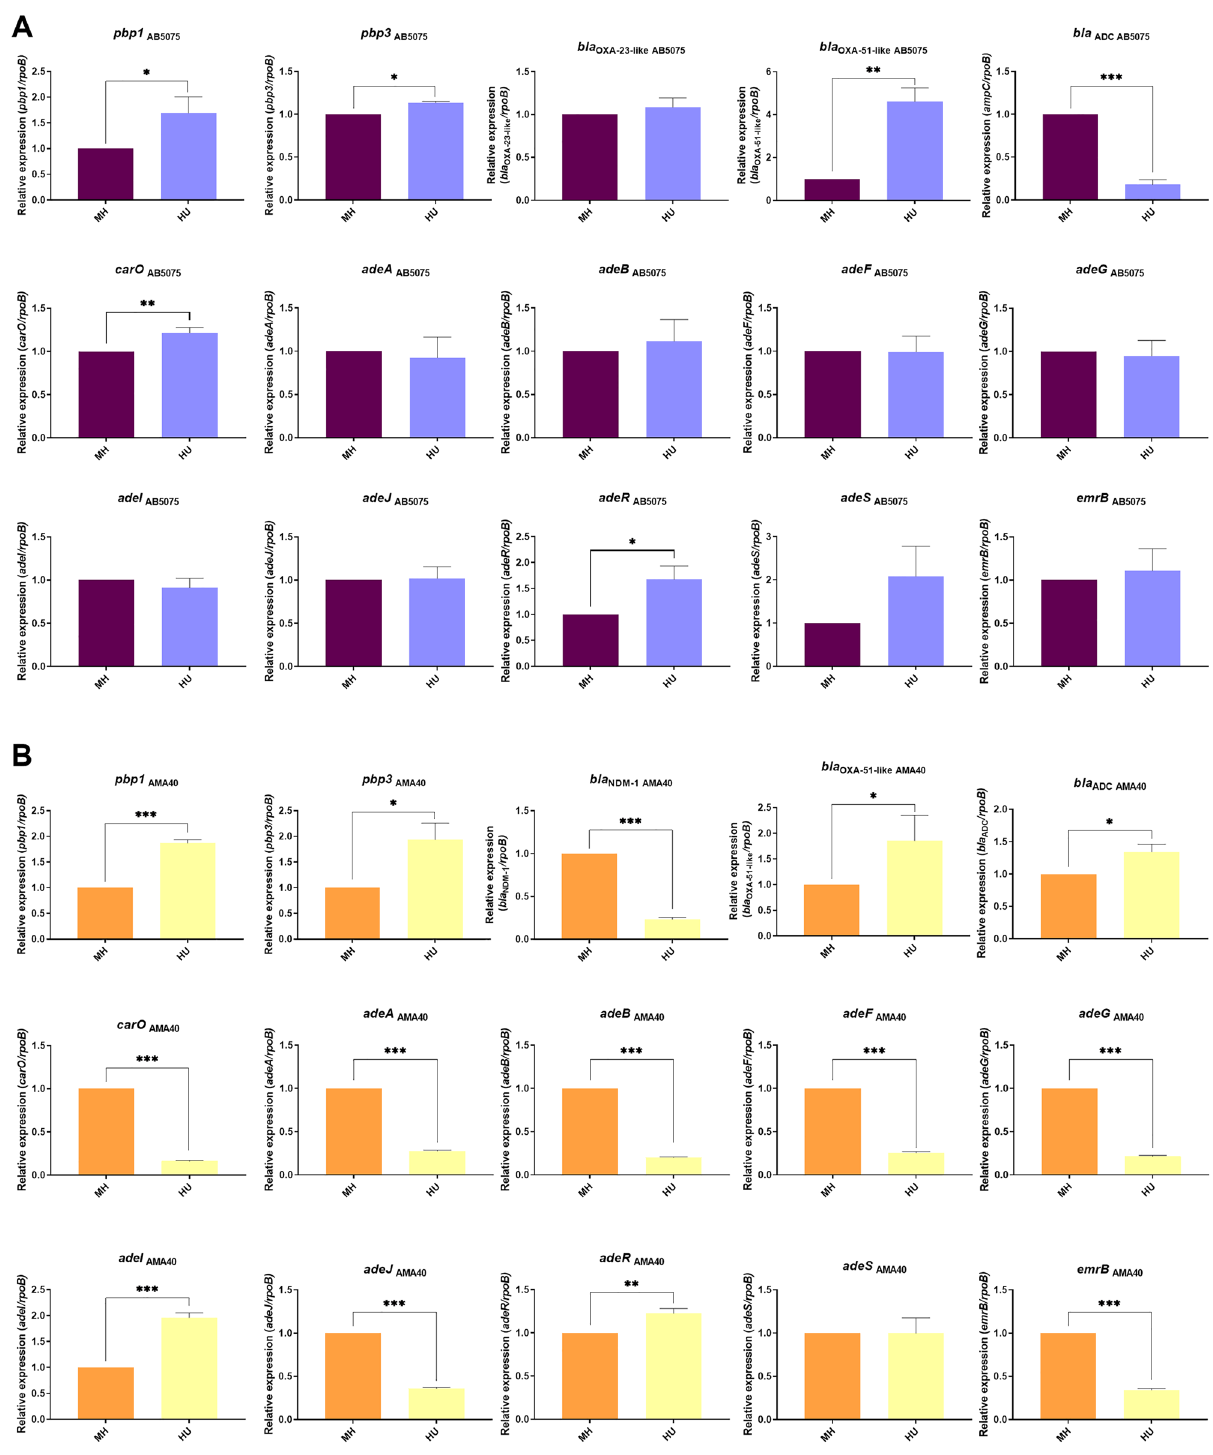
Figure 2. Genetic analysis of β-lactamase and PBP genes of AB5075 ( A ) and AMA40 ( B ) A. baumannii strains. qRT-PCR of genes associated with β-lactams resistance, efflux pump, and porins expressed in cation adjusted Mueller Hinton, cation adjusted Mueller Hinton supplemented with 50% HU. Fold changes were calculated using double ΔCt analysis. At least three independent samples were used. LB was used as the reference condition. Statistical significance ( p < 0.05) was determined by ANOVA followed by Tukey’s multiple- comparison test, one asterisks: p < 0.05; two asterisks: p < 0.01, and three asterisks: p <